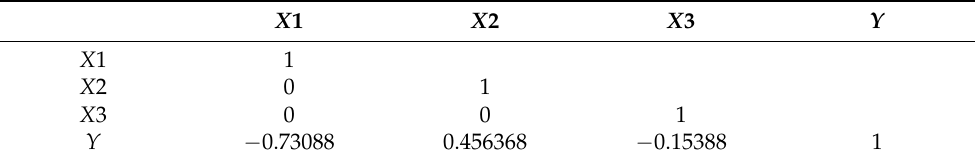
Table 13. Correlation